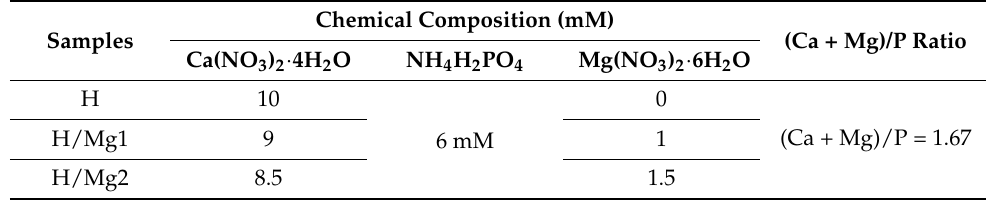
Table 3. Chemical composition of the